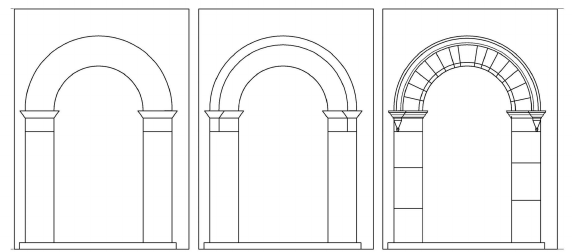
Figure 6. Example of digital family set up according to different levels of Graphic Detail (LOG) modeled in a BIM environment.